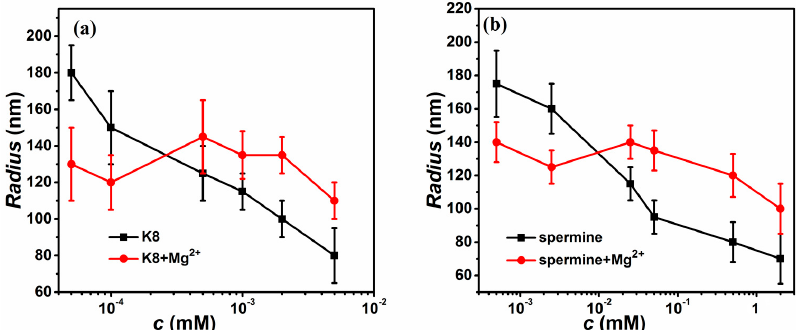
Figure 4. The hydrodynamic radius of condensed DNA as a function of the multivalent ions in a buffer containing di-valent ions (3 mM Mg 2+ ). ( a ) The data for K8, K8-Mg 2+ solution (black, red). ( b ) The data for spermine, spermine-Mg 2+ solution (black, red).